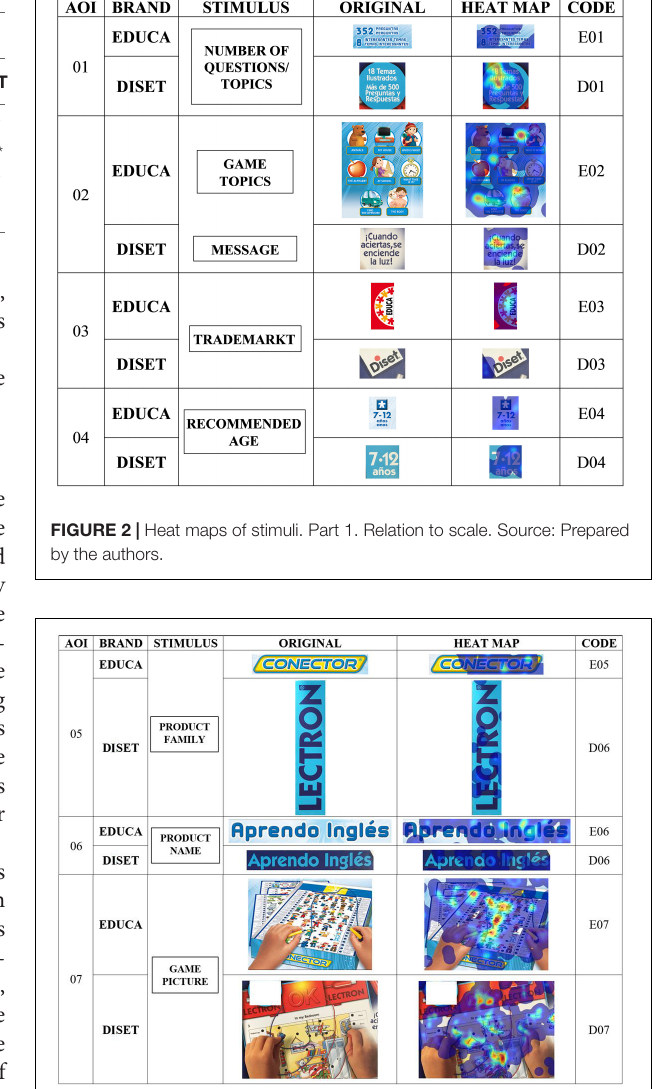
TABLE 2 | Test of Kruskal Wallis ( p * < 0.01).